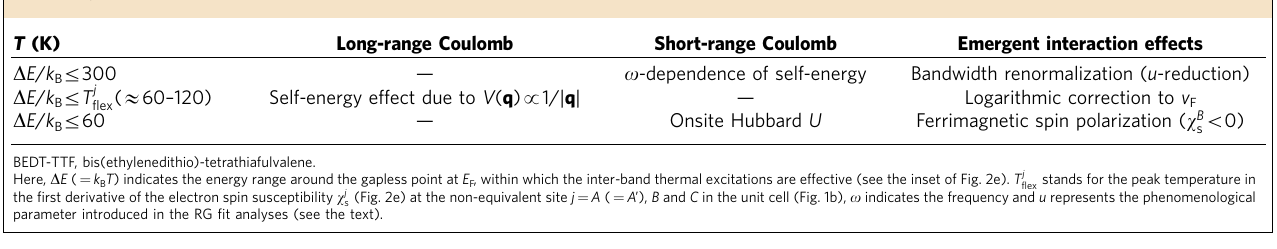
Table 1 | Interaction effects of Dirac fermions in a -(BEDT-TTF) 2 I 3 . T (K)